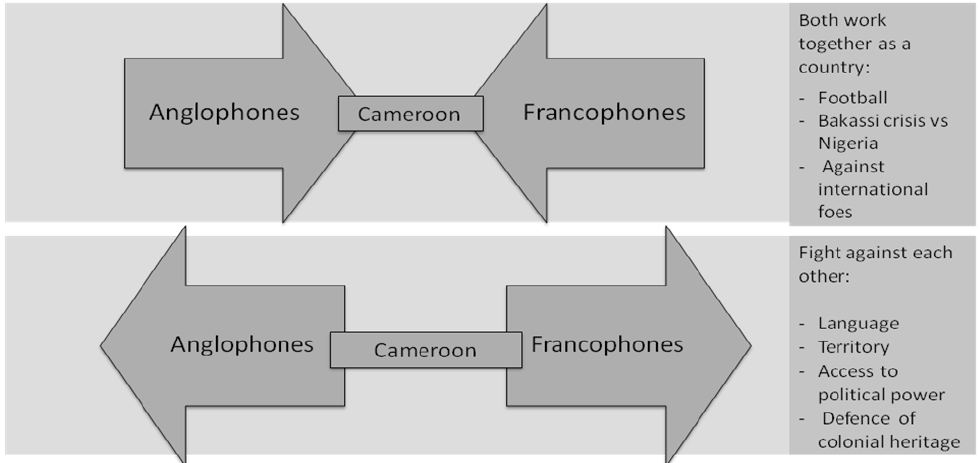
Figure 10. Unity in disunity between anglophones and francophones in